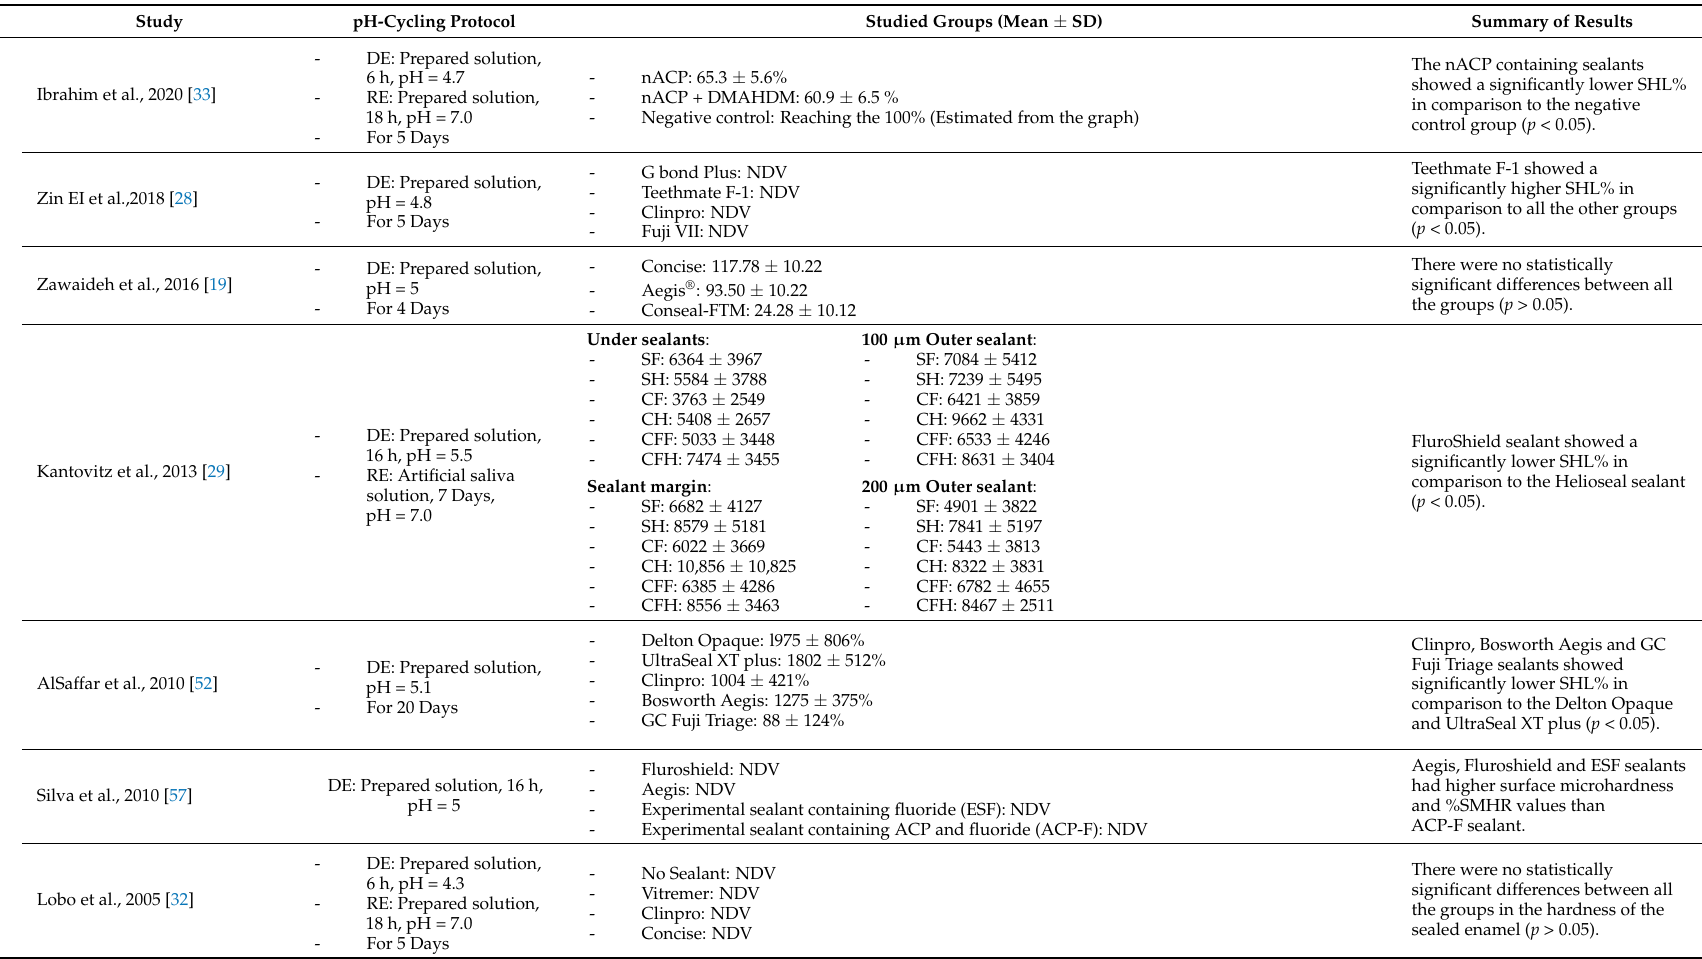
Table 3. Remineralization ability